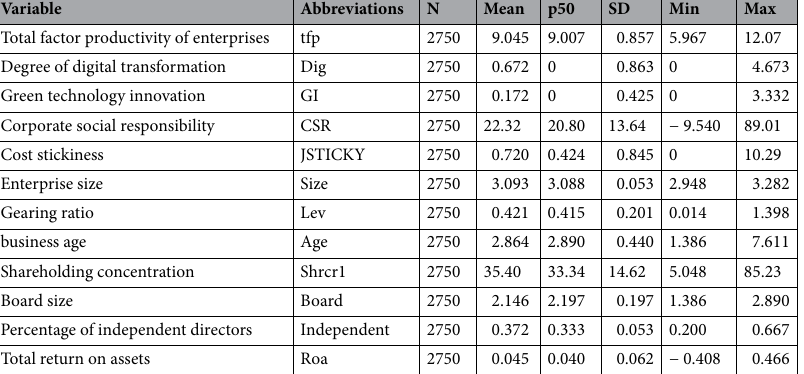
Table 2. Descriptive statistics.